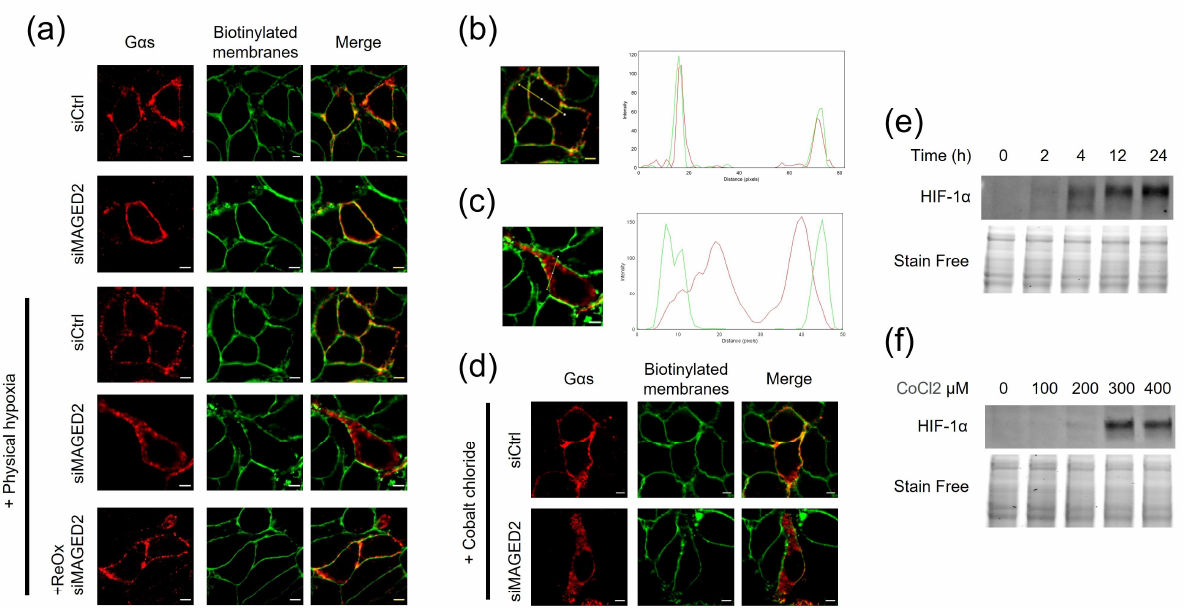
Figure 1. MAGED2 prevents internalization of G α s under hypoxic condition. ( a ) Immunolocalization studies of G α s proteins in presence and absence of MAGED2. HeLa cells were co-transfected with a G α s-HA construct and control or MAGED2 siRNA. Forty-eight hours post-transfection, growth medium was replaced by DMEM serum free and cells were exposed to physical hypoxia (1% oxygen overnight), as indicated. Membrane proteins of HeLa cells were biotinylated at 4 ◦ C. Scale bars, 5 µ m. ( b , c ) Using the “RGB profile plot” plugin in ImageJ, we determined the pattern distribution of G α s (red) in comparison to the biotinylated membrane proteins (Green) in the absence ( b ) or presence ( c ) of MAGED2 siRNA under hypoxia. ( d ) Immunolocalization studies of G α s proteins in presence and absence of MAGED2 under chemical hypoxia. HeLa cells were co-transfected with a G α s-HA construct and control or MAGED2 siRNA. Forty-eight hours post-transfection, growth medium was replaced by DMEM serum free and exposed to chemical hypoxia (300 µ M CoCl 2 ), as indicated. Membrane proteins of HeLa cells were biotinylated at 4 ◦ C. Scale bars, 5 µ m. ( e ) cells were treated with physical hypoxia (1% O 2 , 5% CO 2 , 94% N 2 ) for the specified times. ( f ) cells were treated with chemical hypoxia with the indicated dose of CoCl 2 for 14–16 h. Chemical hypoxia. ( e , f ) Total cell lysates were separated by SDS-PAGE and probed with anti-HIF-1 α